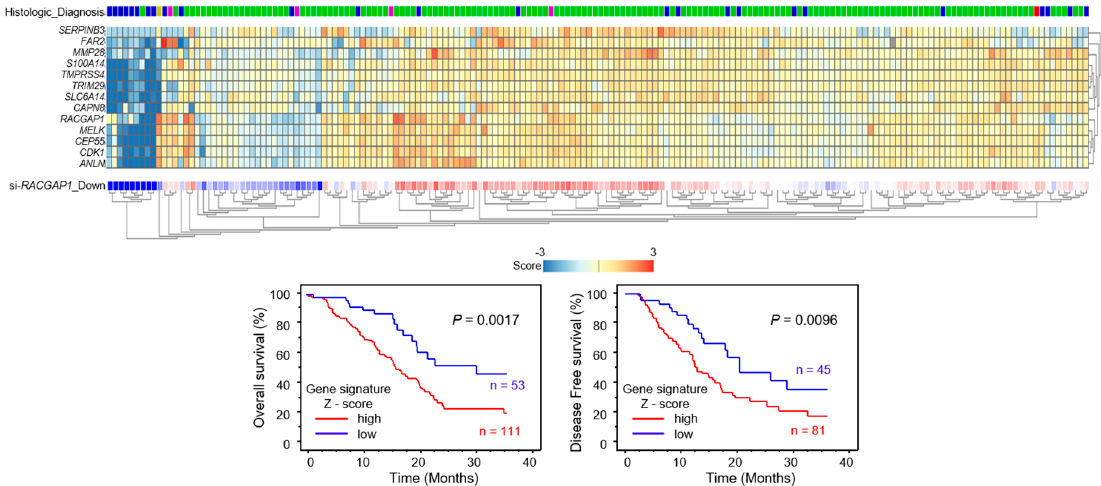
Figure 7. Combination analysis with heatmap of 12 target genes related to poor prognosis in PDAC. Heatmap was created using analysis webcite “R2: Genomics Analysis and Visualization Platform (http://r2.amc.nl)”. Z-score was evaluated by a combination of si- RACGAP1 downstream genes based on TCGA datasets. High group (mRNA Z-score > 0) and low group (mRNA Z-score ≤ 0) are displayed as Kaplan–Meier plots with log-rank tests.